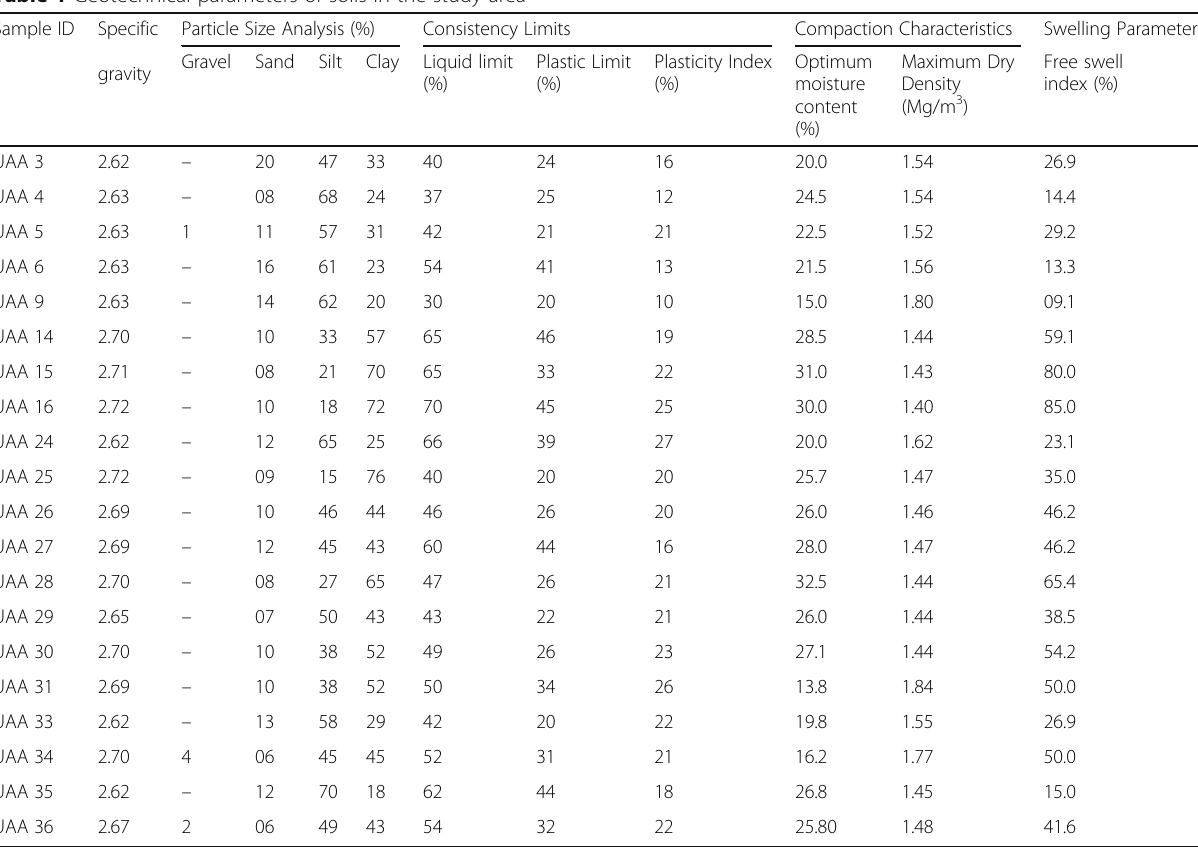
Table 1 Geotechnical parameters of soils in the study area Sample ID Specific